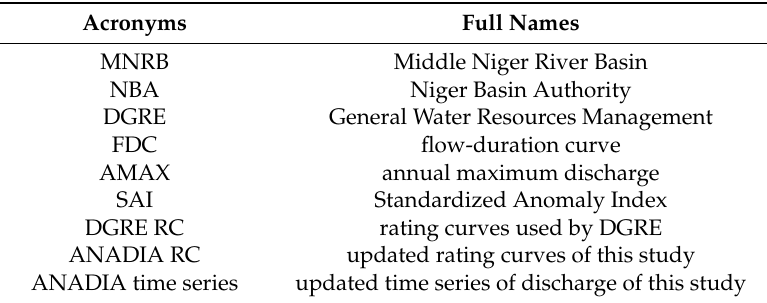
Table 1. The glossary of acronyms used in the